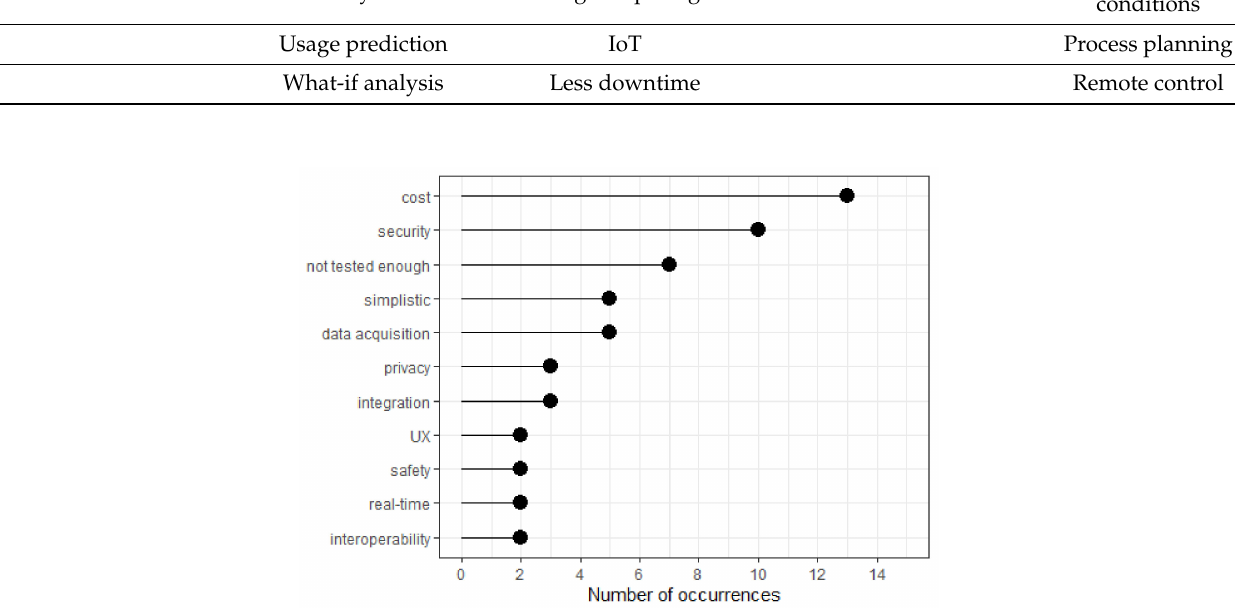
Figure 5. Most mentioned technological obstacles in papers. Table 4. Obstacles identified in